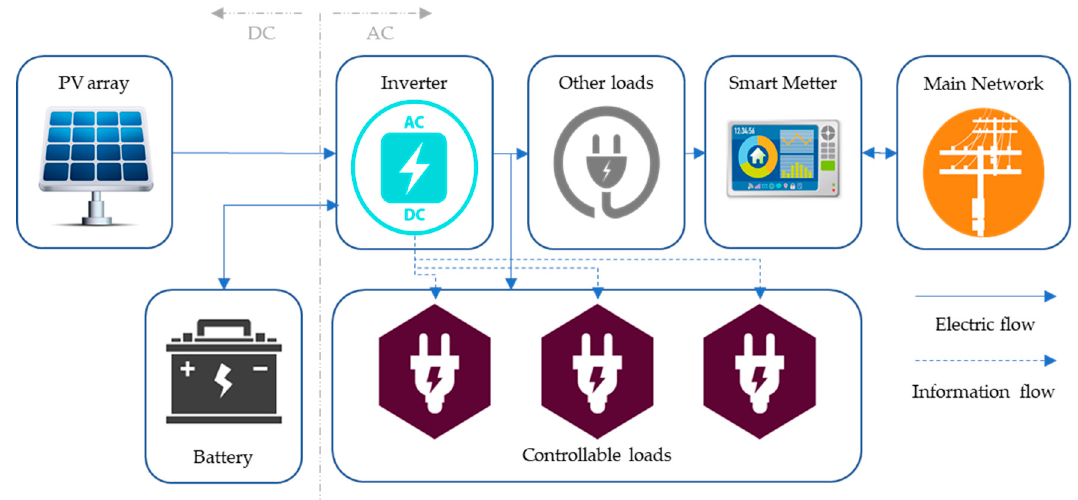
Figure 1. Implementation scheme of the proposed work.